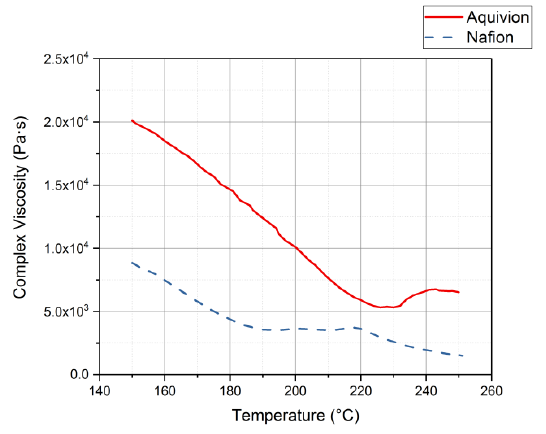
Figure 11. Complex viscosity results from the rheology tests conducted on the precursor-ionomers.